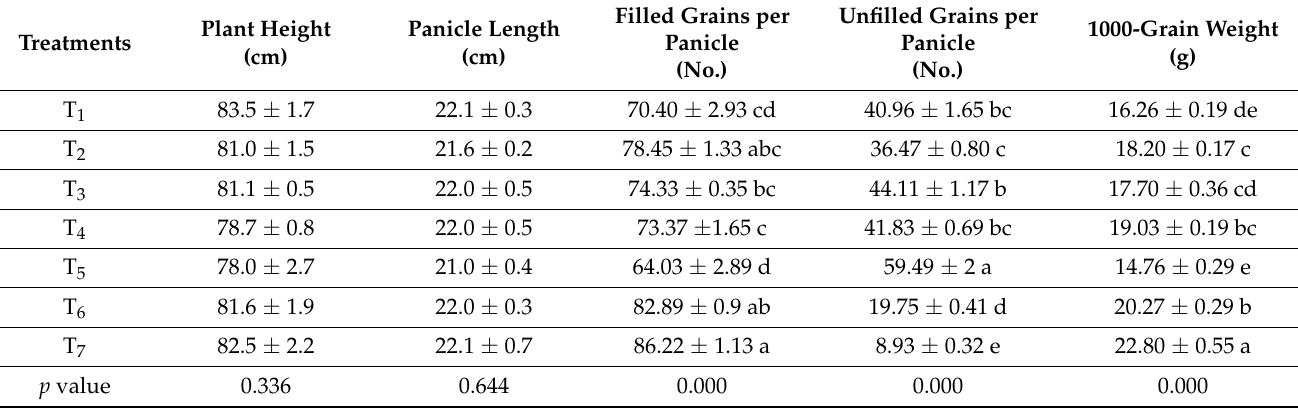
Table 2. Effects of water management on plant growth parameters of BRRI dhan28.